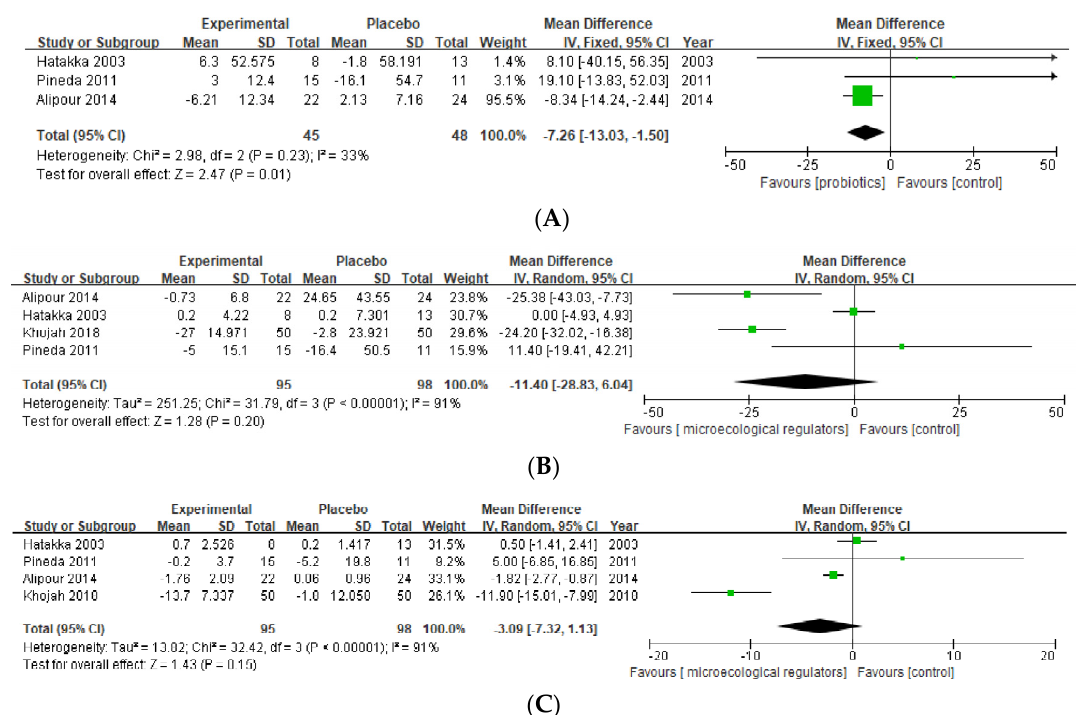
Figure 9. ( A ) Forest plot of IL-1 β variations in rheumatoid arthritis; ( B ) forest plot of IL-6 variations in rheumatoid arthritis; ( C ) forest plot of TNF- α variations in rheumatoid arthritis [36,40,42,44].